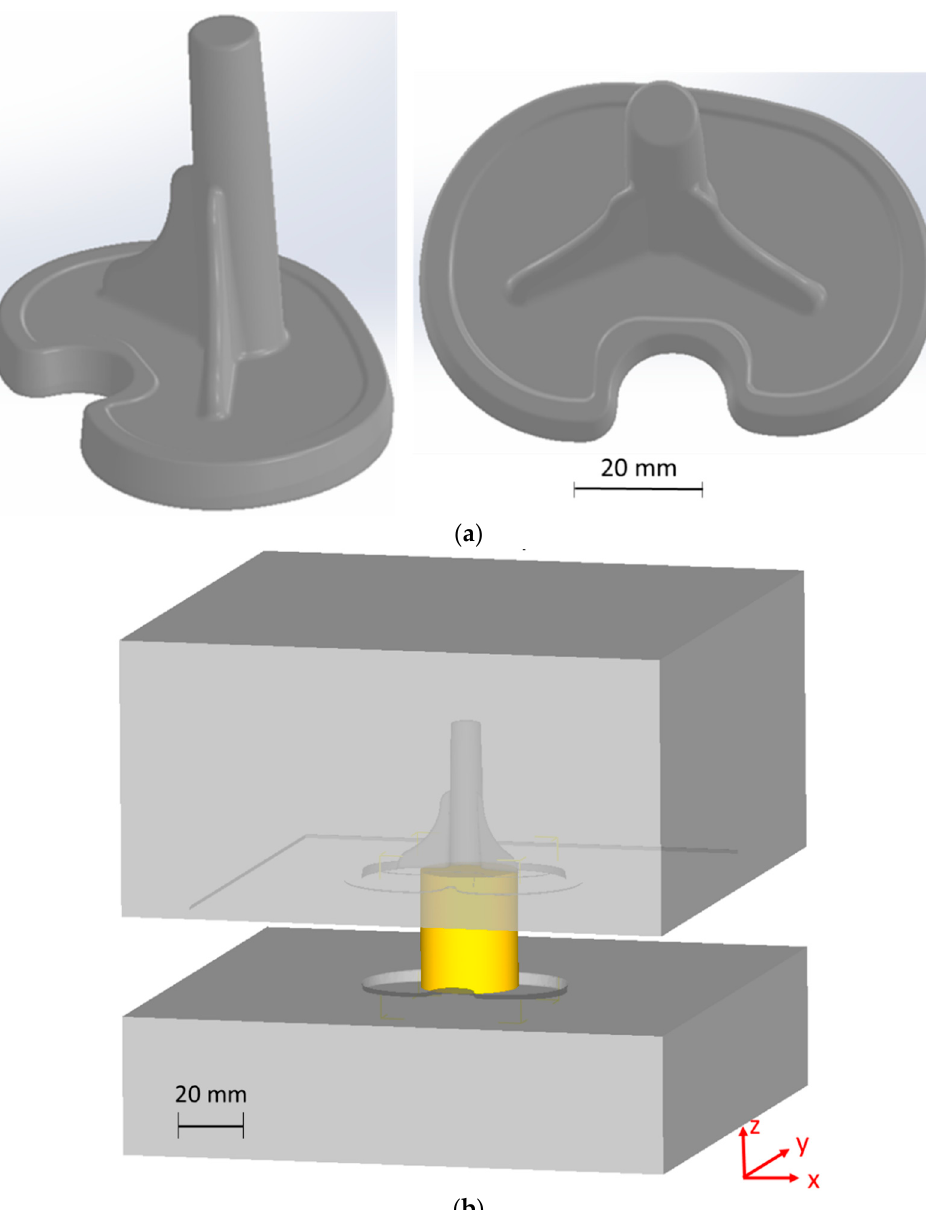
Figure 1. ( a ) Final forged titanium alloy component, for a medical implant application. ( b ) Modelling schematic showing upper (recessed) tooling, lower tooling and initial cylindrical billet.